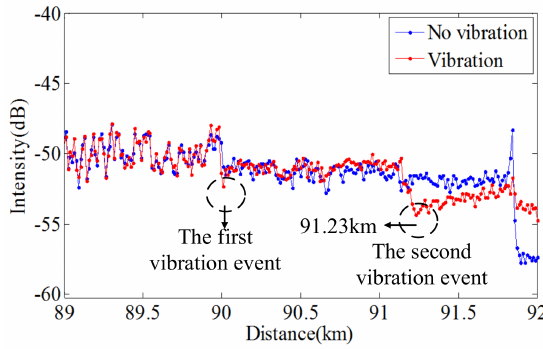
Figure 23. Measured spatial Rayleigh backscattering trace. An obvious “V” shape characteristic at 91.23 km can be used to located the second vibration event (reprinted from Ding et al. [55] with permission of IEEE; copyright